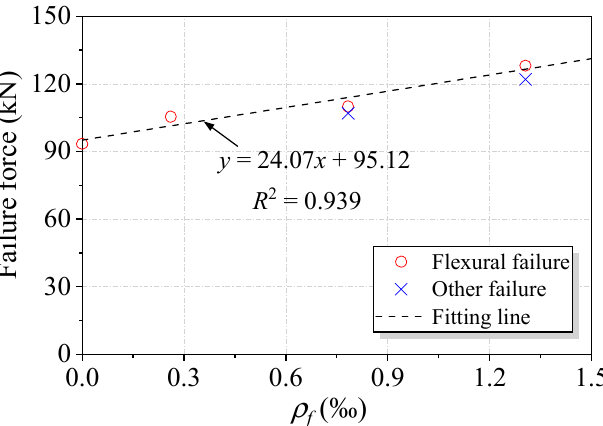
Figure 10. Relationship between the failure force and the textile reinforcement amount for the tested beams. Figure 11 shows the strains in basalt textile for strengthened beams. The textile strain culminated near the midspan within the constant moment region and diminished as the distance from the midspan increased for small applied forces. When increasing the applied force, the textile strain at one end rose quickly, exceeded the midspan strain for B3 and B5, and eventually led to the development of end debonding, as shown in Figure 8. The strain gauge at the end of the textile stopped reading after 100 kN for B5. If the end anchorage was installed, the textile strain diminished at the end, indicating the beneficial effects